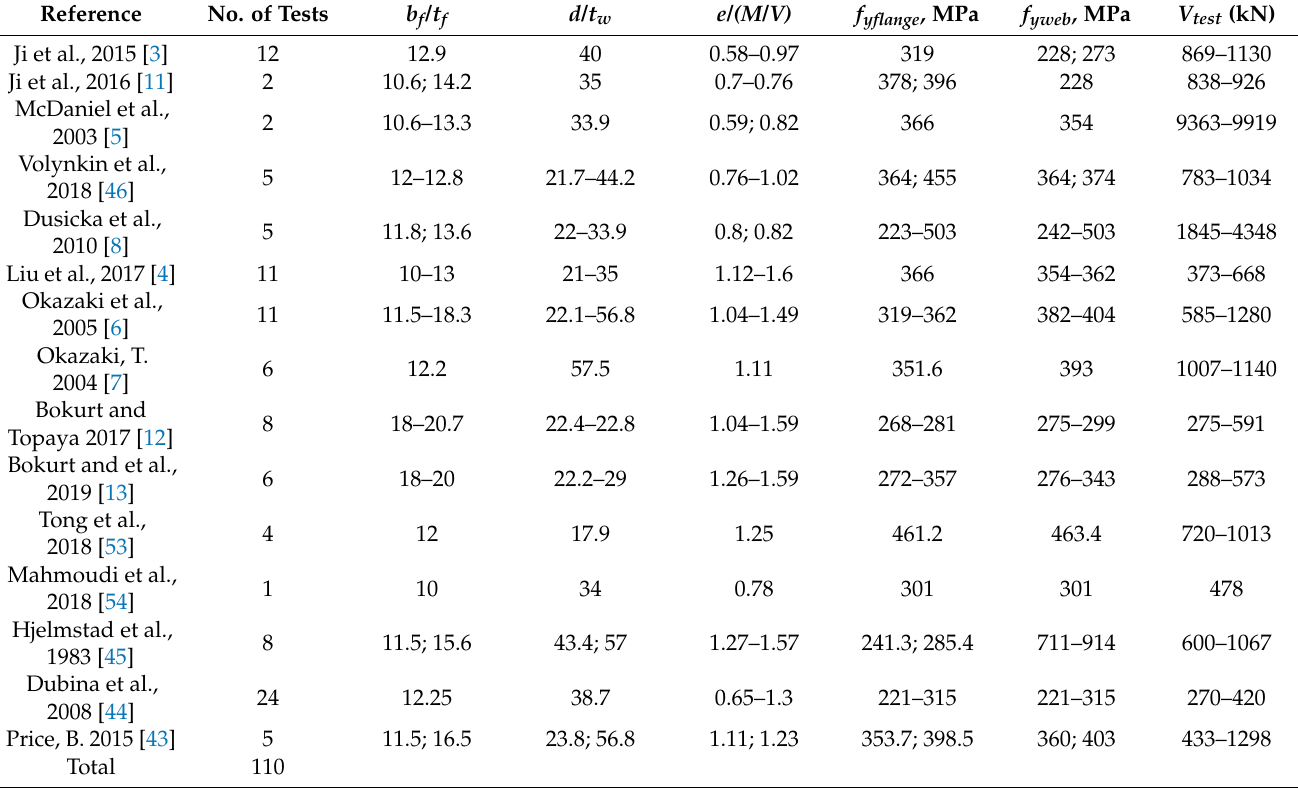
Table 2. Database description of short links.